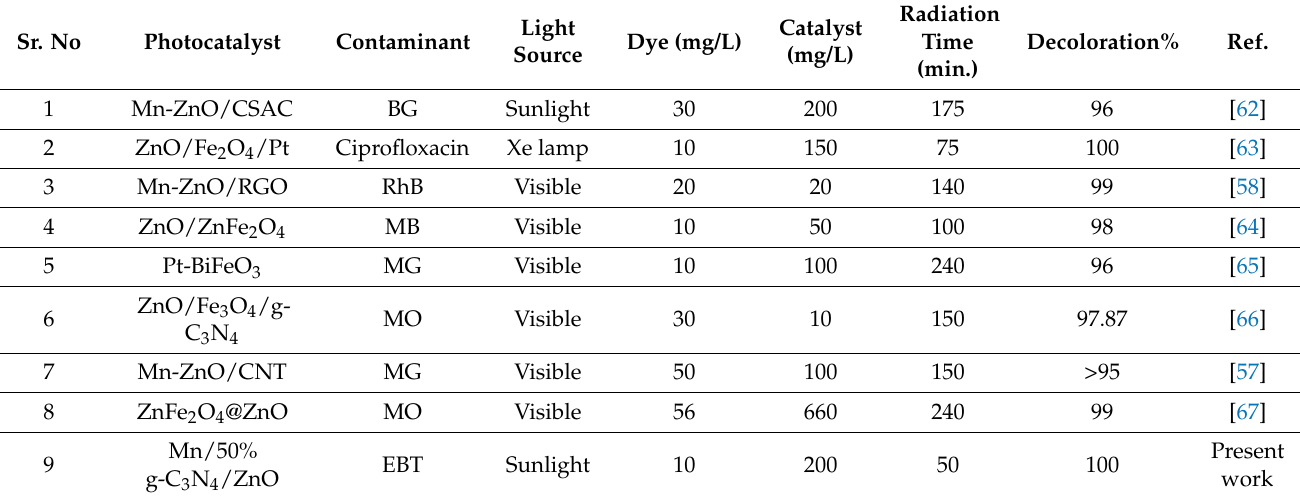
Table 1. Comparison of decoloration capabilities of Mn/50GZ with some earlier works.